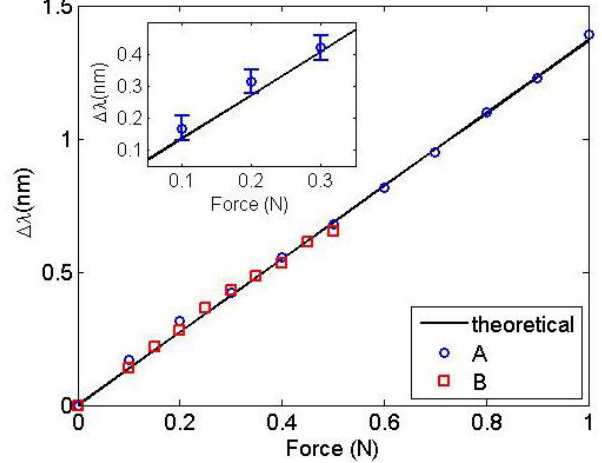
Figure 5. Bragg wavelength shift as a function of the force between sensors A and B and the ferromagnetic plate. The solid line was obtained from Equation (2). The inset shows a detail of sensor A measurements with error